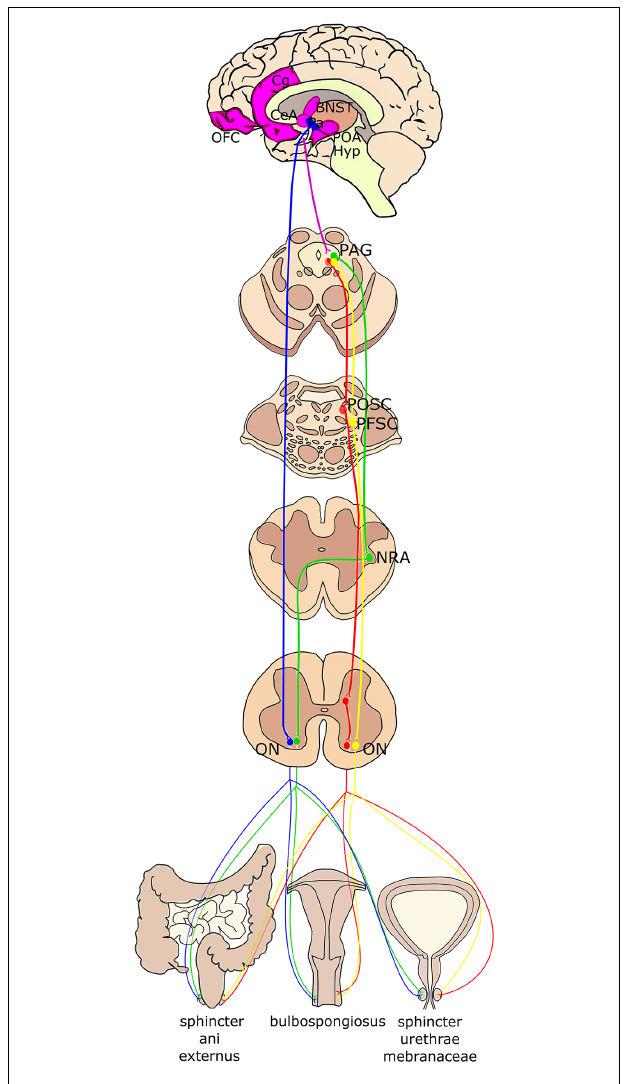
FIGURE 3 | Schematic summary of the higher-order projections to Onuf’s nucleus. Onuf’s nucleus (ON) receives direct projections from the paraventricular hypothalamic nucleus (Pa; in blue). The periaqueductal gray (PAG) in the mesencephalon controls the pelvic floor by stimulating the pelvic organ stimulating center (POSC; in red), which in turn projects to inhibitory interneurons in the sacral cord that finally innervate Onuf’s nucleus. Moreover, PAG sends efferent fibers to the nucleus retroambiguus (NRA; in green) in the medulla, which is then connected with Onuf’s MNs, which innervate the muscles determining the abdominal pressure. The strongest afferents to the PAG originate from different brain areas (identified in purple), such as the medial orbitofrontal cortex (OFC), the anterior cingulate gyrus (Cg), the preoptic area and hypothalamus (POA, Hyp), the lateral Bed Nucleus of Stria Terminalis (BNST) and the Central Nucleus of the Amygdala (CeA). Finally, projections from the limbic system and prefrontal cortex reach the PAG that then projects to the pelvic floor stimulating center (PFSC; in yellow) in the pons, which in turn innervates Onuf’s